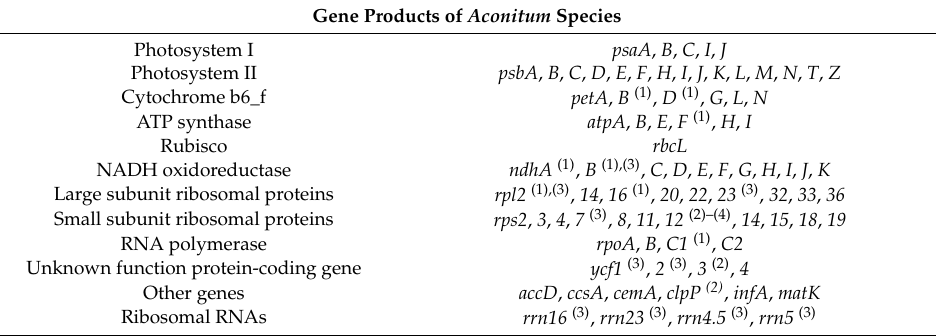
Table 2. Genes present in the CP genomes of A. pseudolaeve Nakai and A. longecassidatum